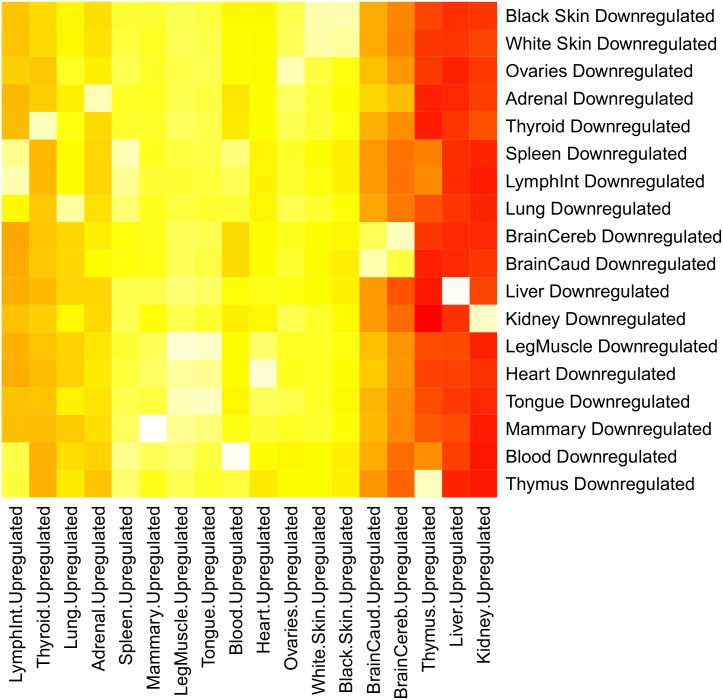
Differential expression heat map of class 3 lncRNA.This heat map shows the number of transcripts that either upregulated or downregulated for each tissue. On the x-axis are the upregulated tissues. On the y-axis are the downregulated tissues. The tissues are ordered and grouped based on upregulation. Red colors indicating the most differential expression, while white colors indicate the least differential expression.